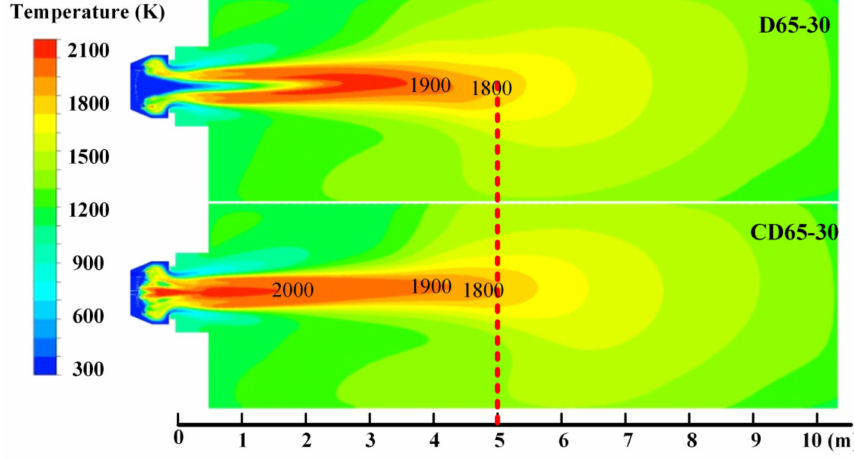
Figure 8. Temperature distribution of D65-30 and CD65-30 on the center cross section.